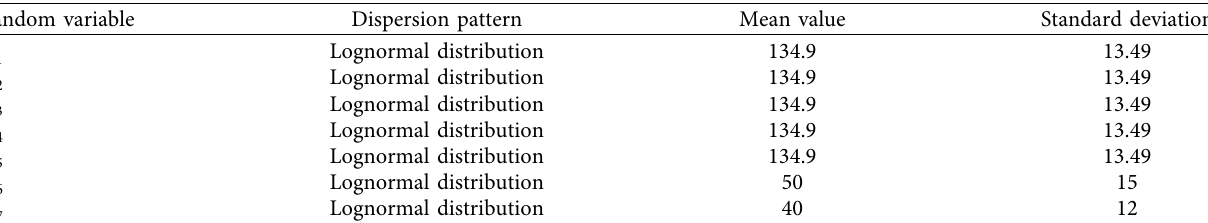
Figure 6: Plane frame work. Table 5: Random variable distribution of example 4.